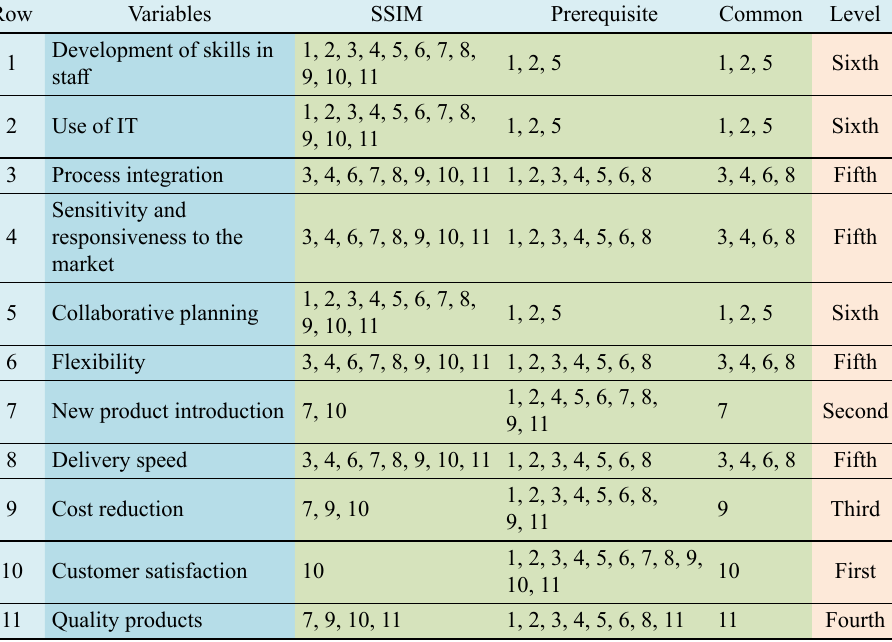
Table 6. Determining the level of the